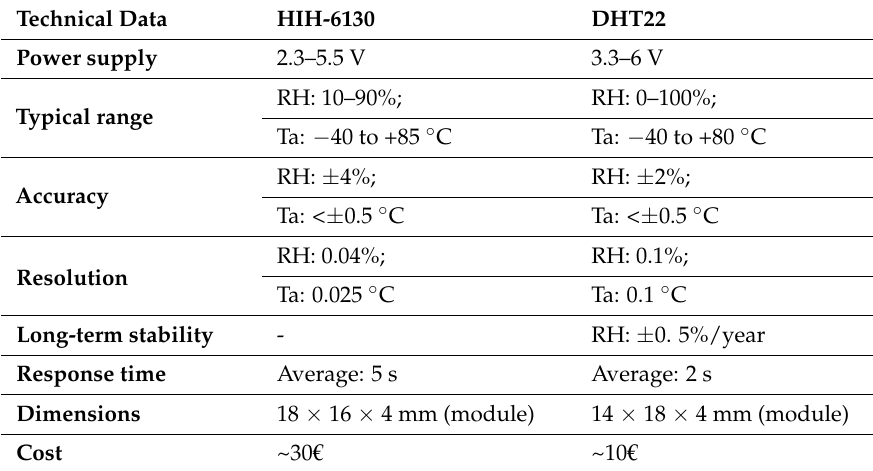
Table 2. Technical characteristics of the considered thermohygrometric